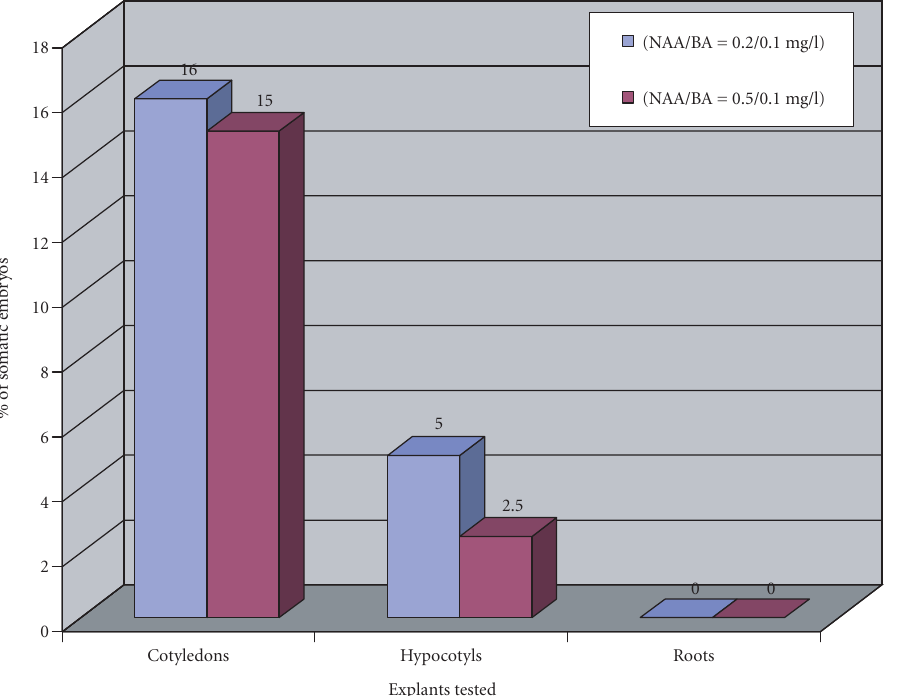
Figure 3: Somatic embryogenesis obtained from roots, cotyledons, and hypocotyls of Papaver somniferum album , with two plant growth regulator combinations (NAA/kinetin = 0 . 2 / 0 . 1 and 0.5/0.1mg/l), after four months of culture.